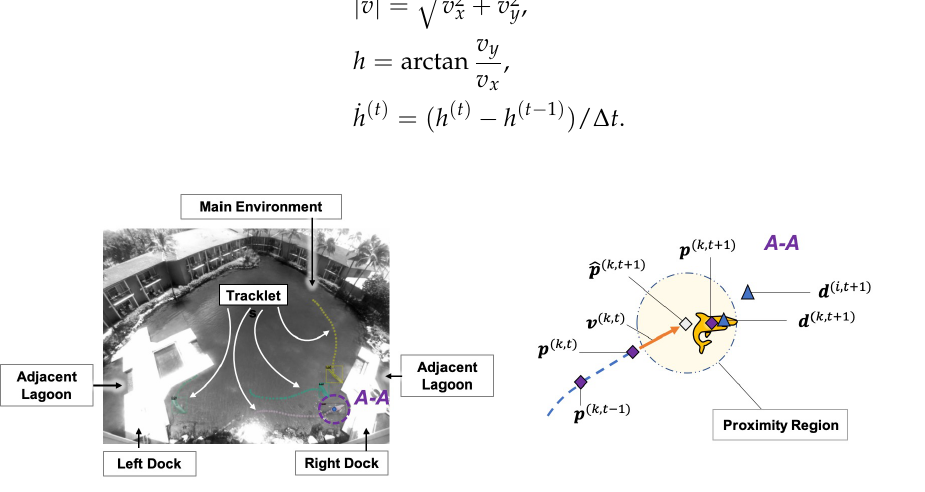
Figure 2. ( Left ) Detections and tracklets are shown for four animals in the lagoon. ( Right ) An illustration of the tracklet prediction-association-filtering process. Where for tracklet k the current filtered position is p ( k , t ) , the current filtered velocity is v ( k , t ) , the Kalman-predicted future position is ˆ p ( k , t + 1 ) and the detection selected for filtering is d ( k , t + 1 ) , while the filtered position of the animal at the next step is p ( k , t + 1 ) . d ( i , t + 1 ) is another detection at ( t + 1) that is not associated with the k -th